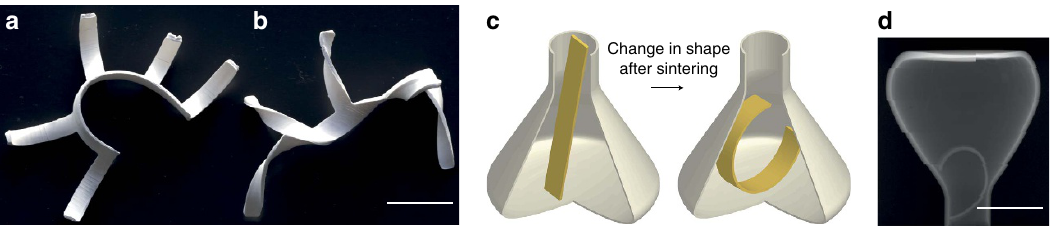
Figure 4 | Programmed self-shaping as a method for designing complex ceramic pieces. Ceramic parts with complex shapes resulting from site-specific ( a ) bending or ( b ) twisting effects on sintering (scale bar, 20mm). ( c ) Cartoon illustrating a ceramic piece with complex shape that cannot be easily engineered with conventional processing methods. In this simple example, a bilayered consolidated green body is programmed to bend during sintering and become trapped within the ceramic vessel. ( d ) Experimental realization of the effect shown in ( c ), as illustrated by a two-dimensional slice extracted from X-ray tomography of the object after sintering (scale bar,